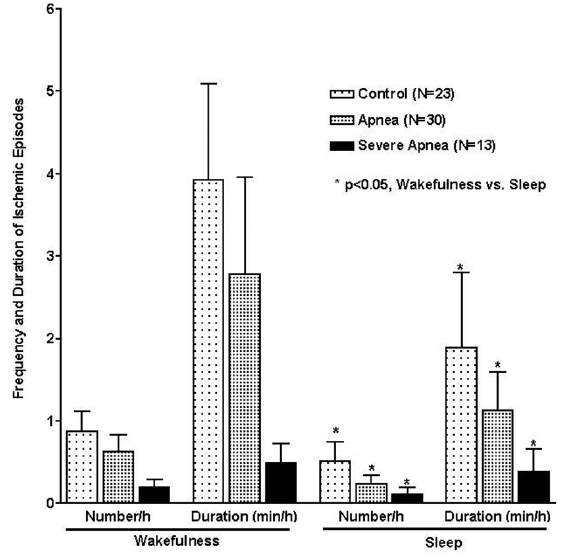
Figure 1 - Comparison of the number and duration of ischemic episodes per hour during wakefulness and sleep in the same group